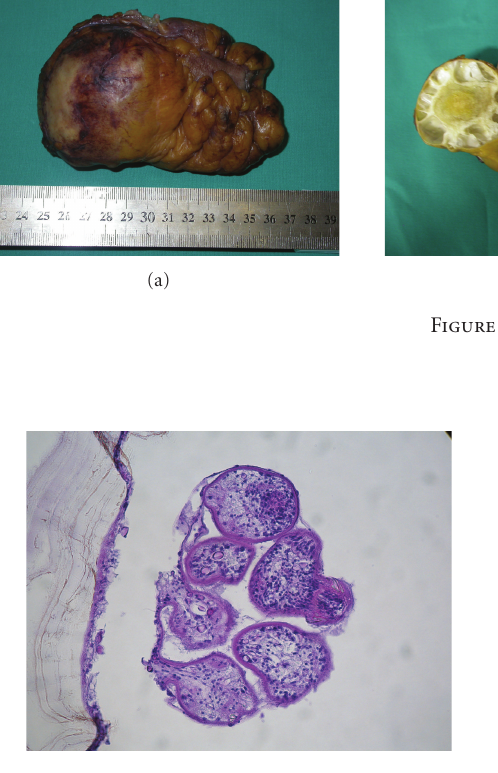
Figure 3: Microscopy